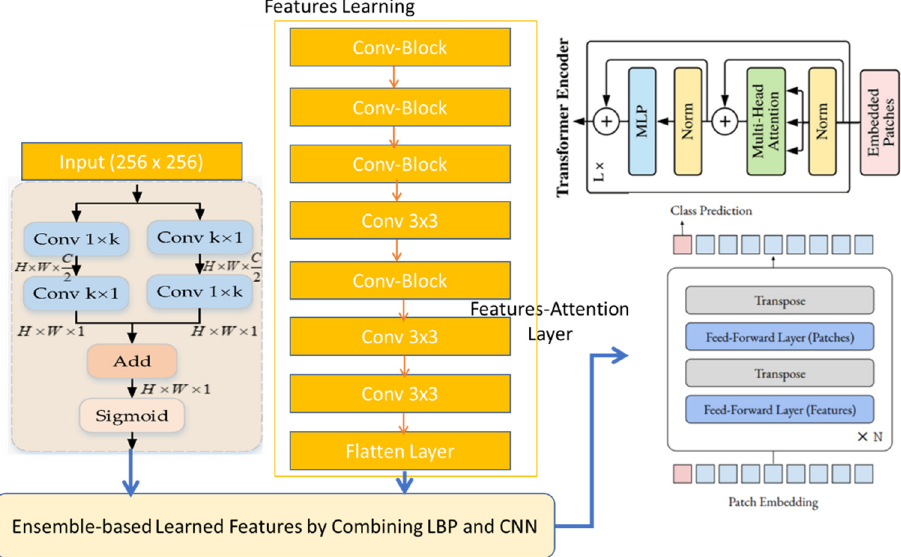
Figure 4. The pipeline of the proposed convolutional vision transformer (CVT) architecture.